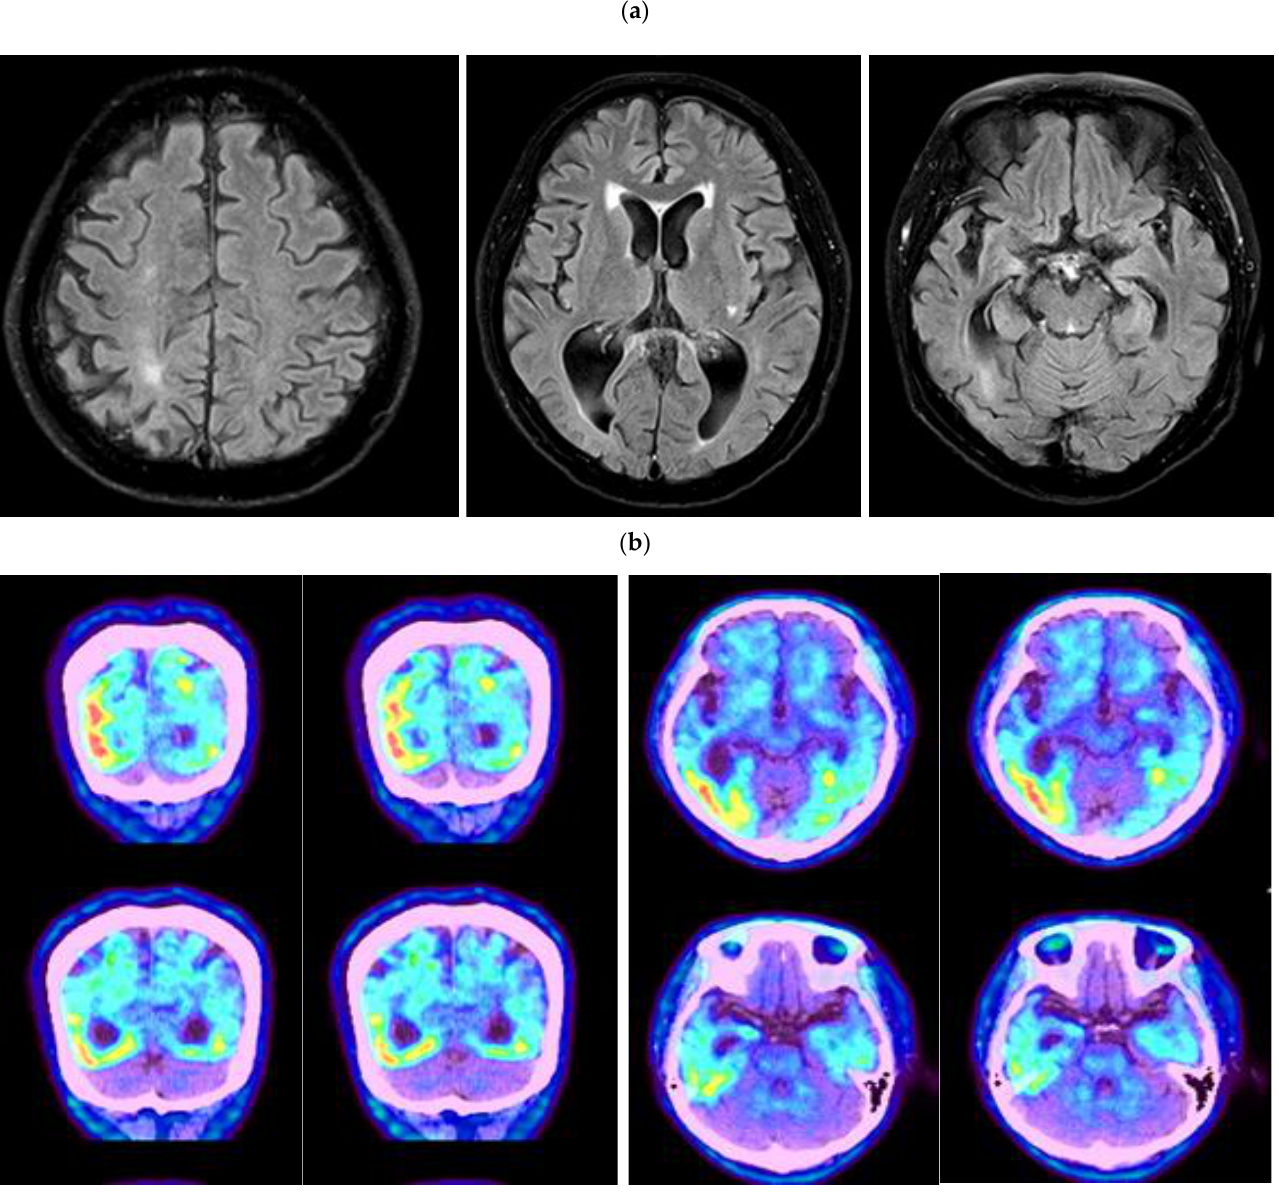
Figure 1. ( a ) Brain MRI of the patient, revealing asymmetric brain atrophies for the entire brain. Brain shrinkage was most prominent in the temporo-parietal lobe. ( b ) Amyloid PET-CT revealed intense amyloid deposits in the gray matter area asymmetrically. Amyloid deposits were prominent in both parietal and temporal lobes, but they were more prominent in the left temporo-parietal